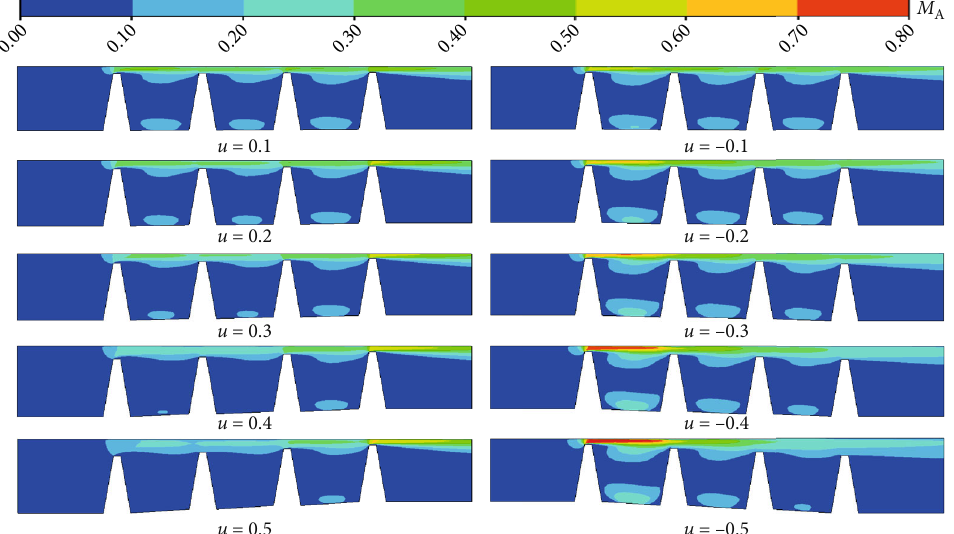
Figure 11: Axial Mach number distributions of nonuniform tip clearance labyrinths in the subcritical state ( Re = 10000 , π = 1 : 3 , M and C = 0 : 067